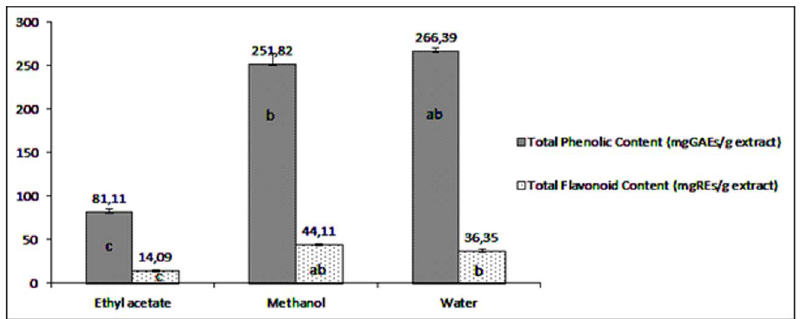
Figure 1. Total phenolic and flavonoid content in three extracts from Cotoneasternummularia ((mean ± SD). In each bar different letters indicate significant difference (p , 0.05). (GAEs: Gallic acid equivalents: REs: Rutin equivalents).